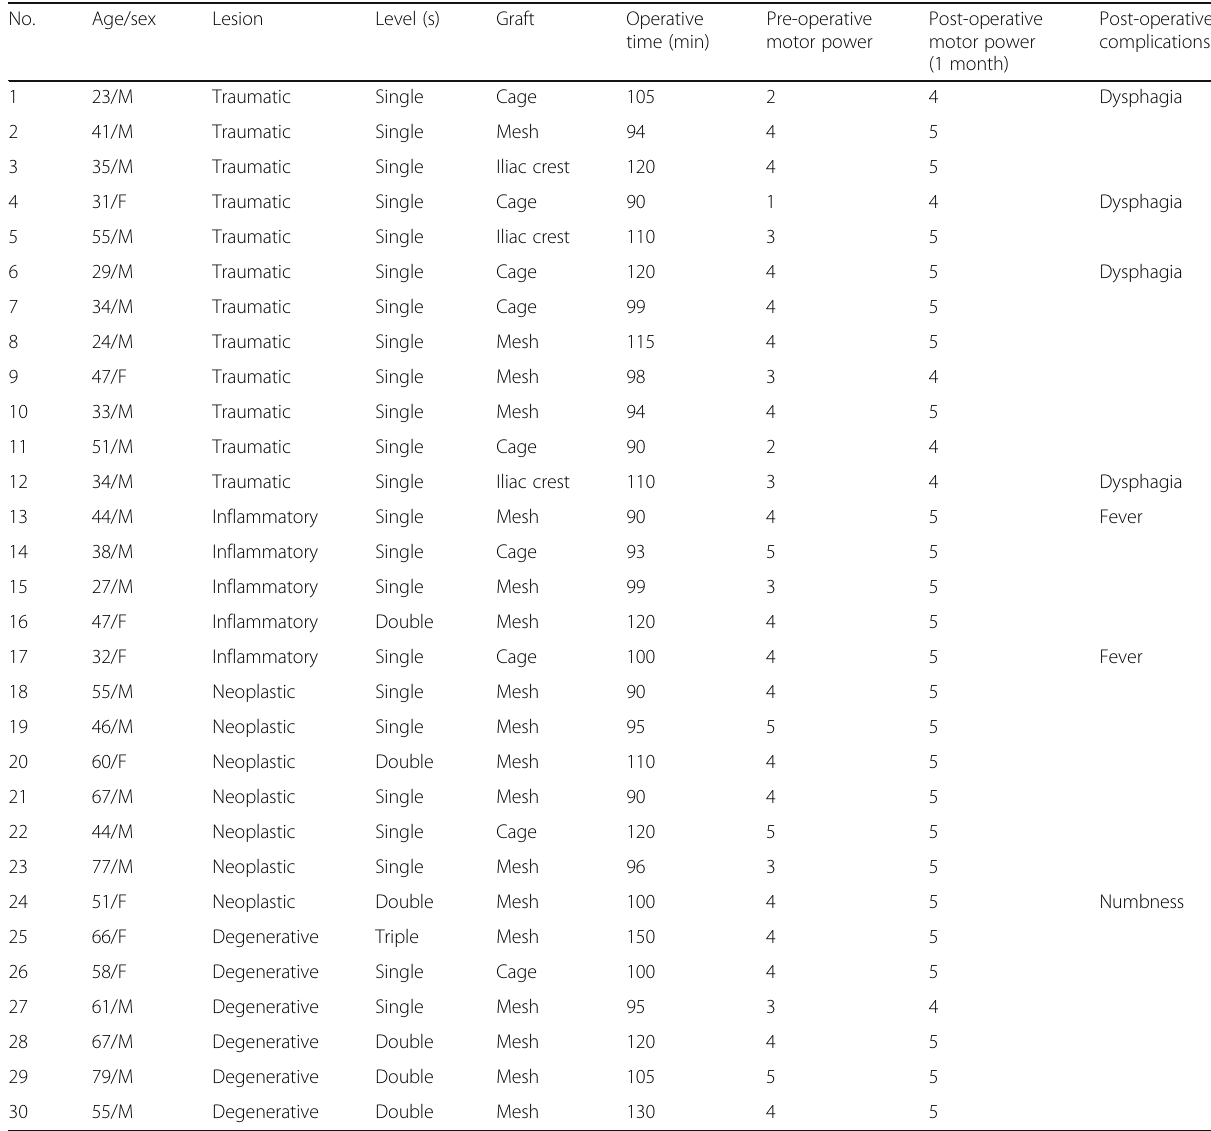
Table 1 Summary of clinical